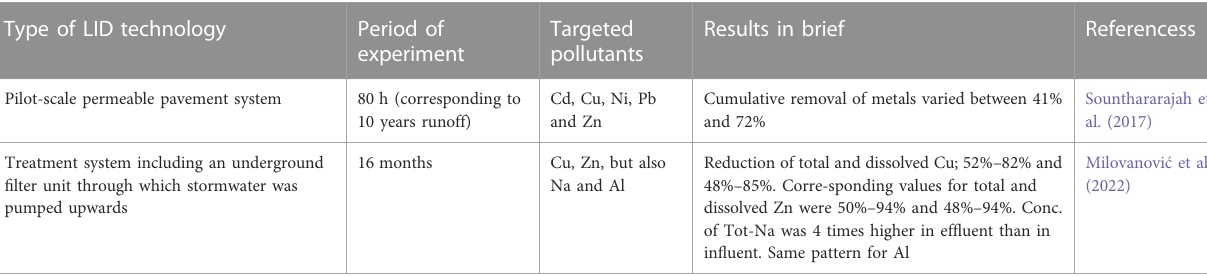
TABLE 7 Low Impact Development facilities including zeolites as fi lter